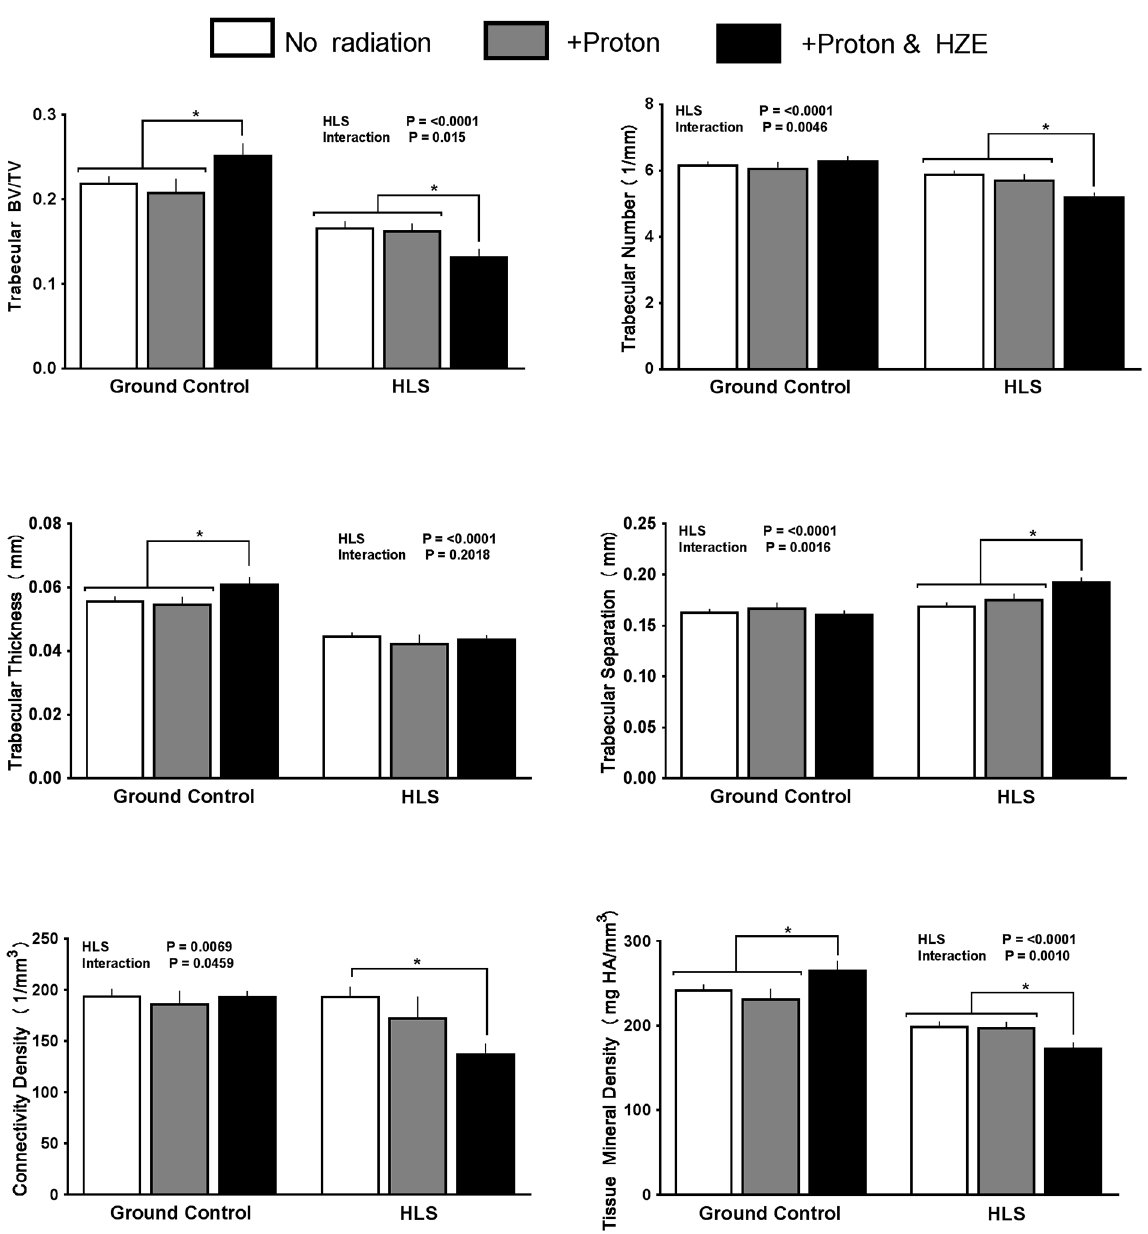
Fig 1. Effect of HLS and radiation on trabecular parameters measuredwith MicroCT scans at distal femur. Measuresare shown as absolute values at conclusion of study for trabecularbone volume fraction (Tb.BVTV), trabecularthickness (Tb.Th), trabecular separation(Tb.Sp), trabecular number (Tb.N), trabecularconnectivitydensity (Conn.Dens)and trabecular tissue mineral density (Tb.TMD). Values are means ± SEM; n = 14–18bones/group.Valueswith line and asterisk indicationsare significantly different (p <